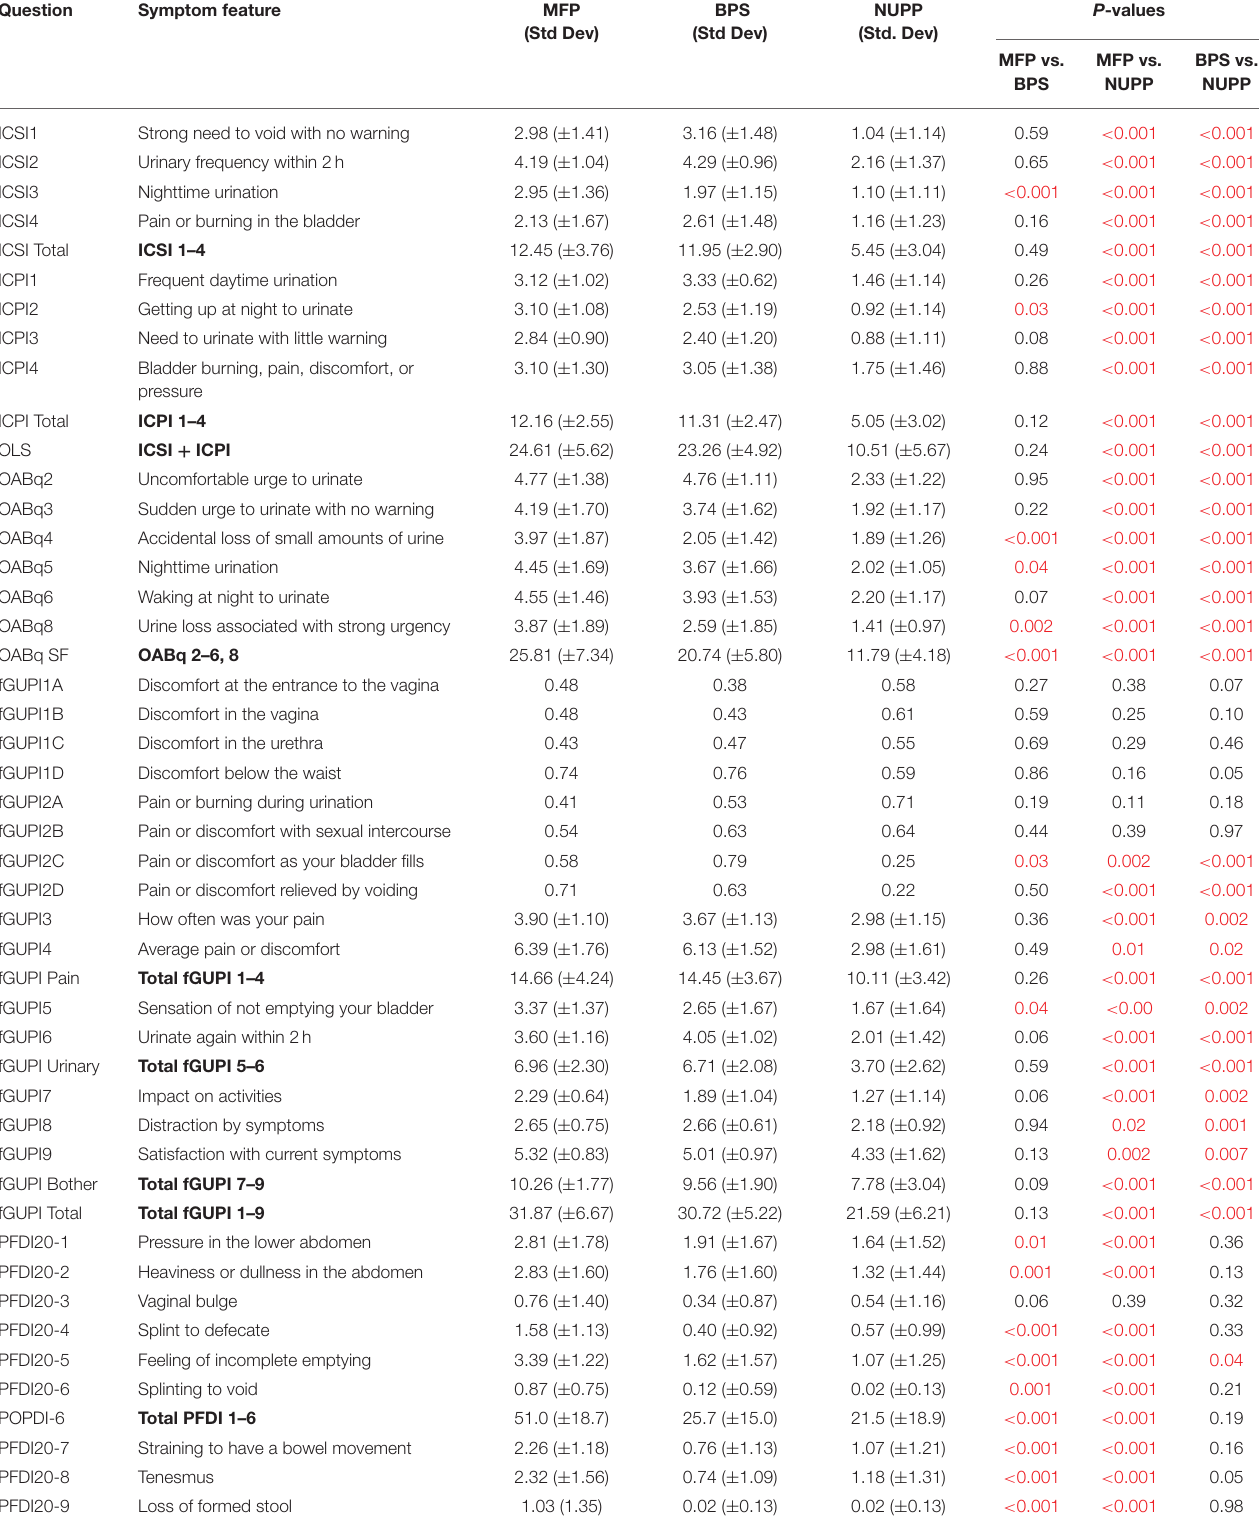
TABLE 2 | Geometric means for patient scores on individual symptomatic